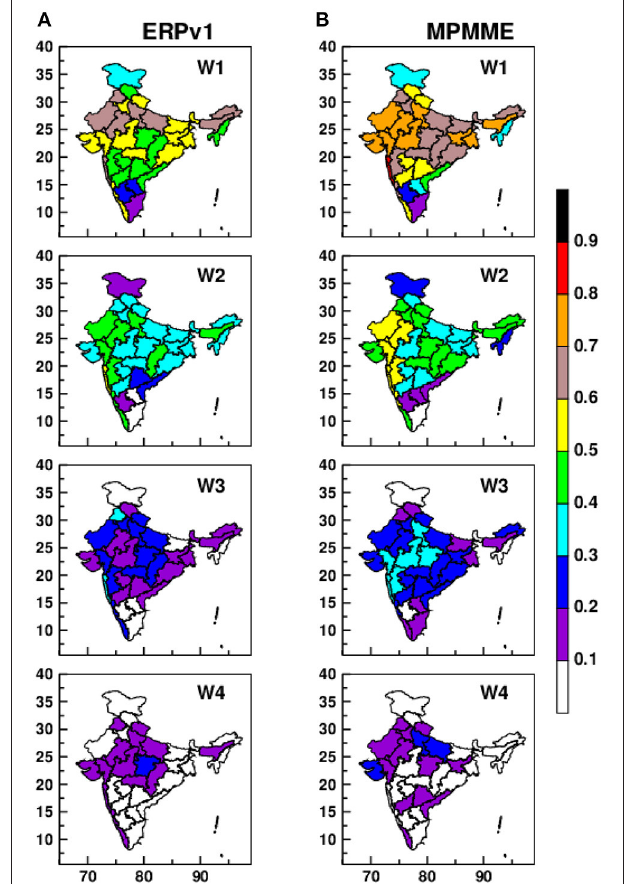
FIGURE 5 | Sub-divisional skill in terms of anomaly correlation coefficient for (A) extended range prediction system (ERPv1) and (B) multi-physics multi-model ensemble (MPMME) during